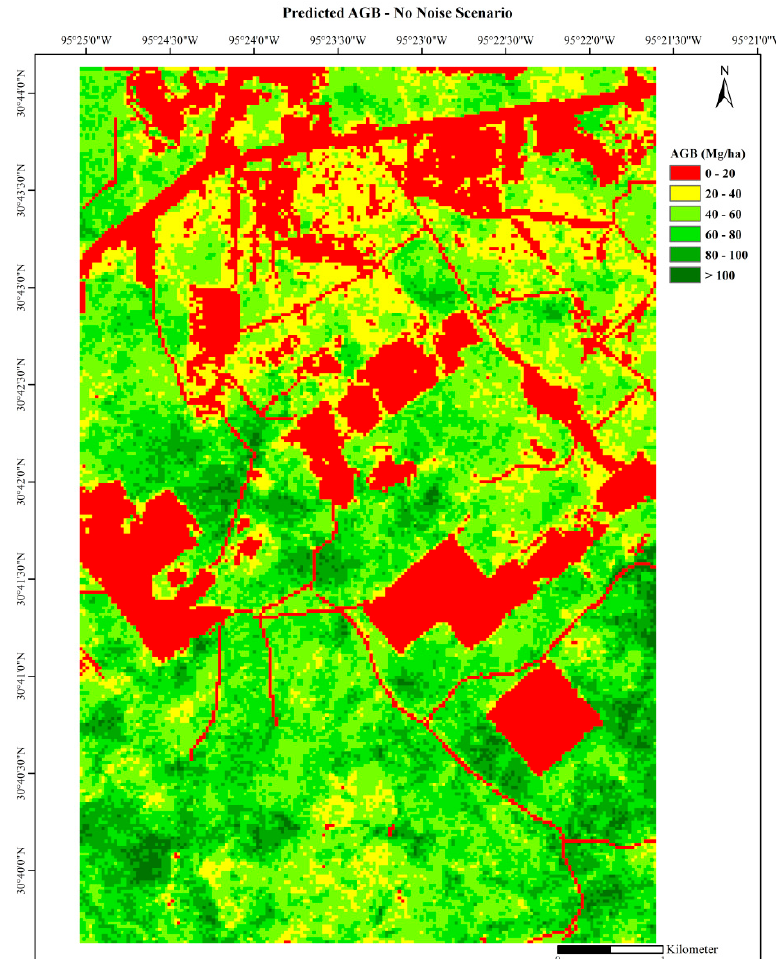
Figure 8. DNN predictions of AGB density at a 30 m spatial resolution for the no noise scenario.